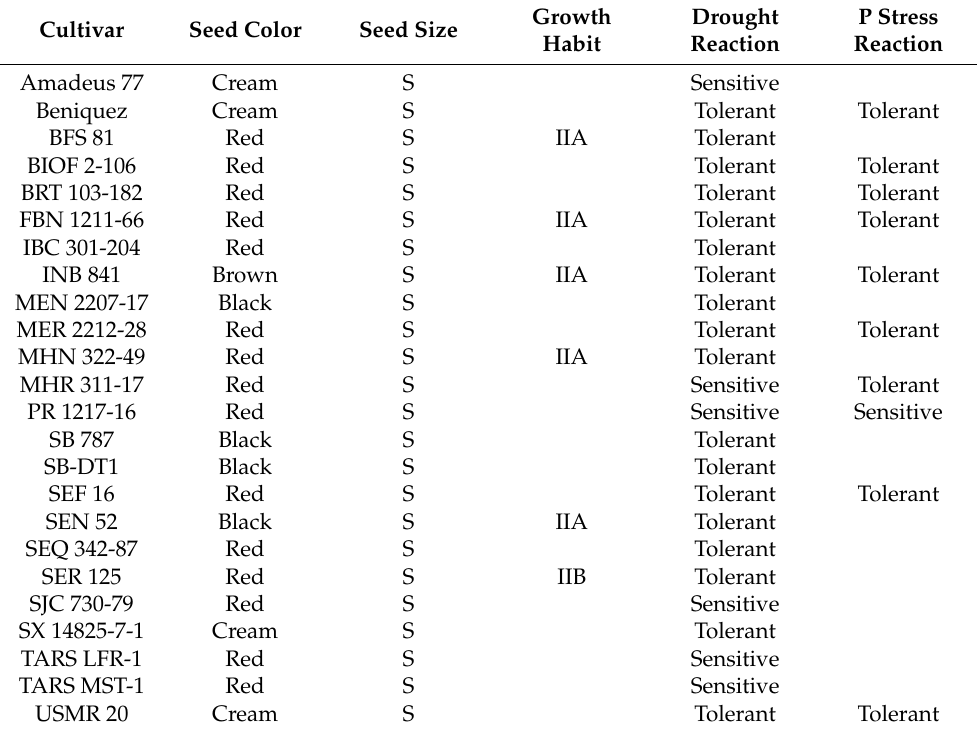
Table 2. Characteristics of common bean cultivars evaluated under water-stressed and unstressed conditions. Cultivar Seed Color Seed Size